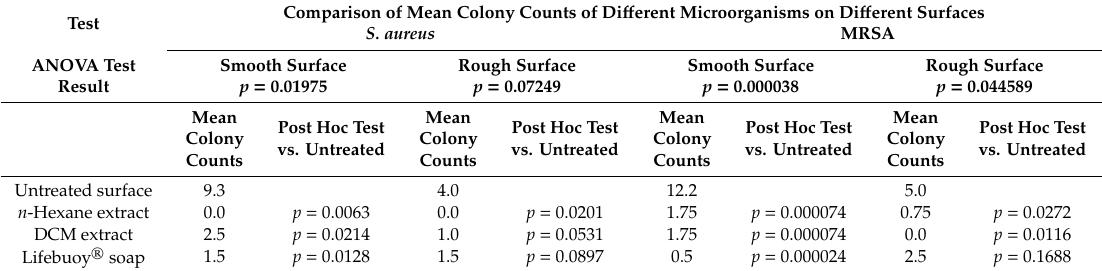
Table A2. Comparison of mean colony counts of di ff erent microorganisms on di ff erent surfaces after treatment with G. cambogia extracts by one-way ANOVA with post hoc multiple